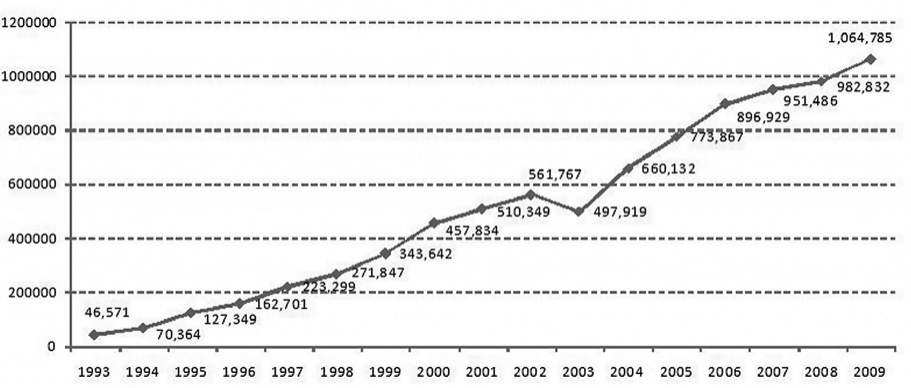
Fig. 1. Worldwide temporal diffussion of ISO